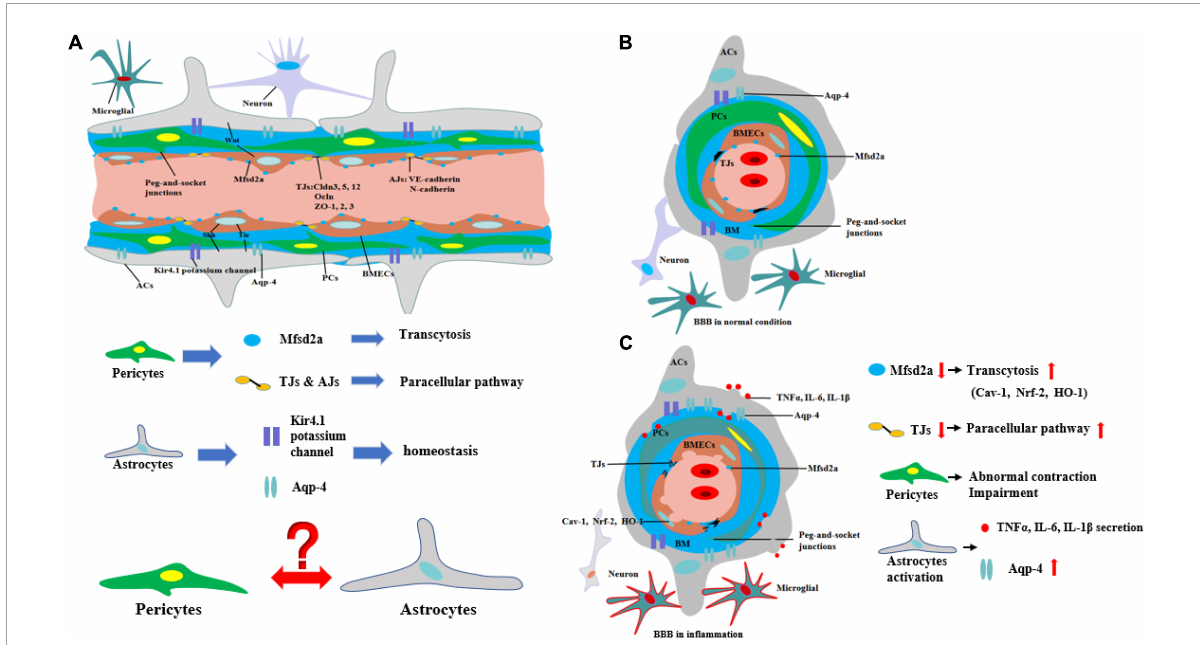
FIGURE1 Structure and biomechanisms of blood – brain barrier during physical or inflammation. (A) The structure of BBB from longitudinal section during physical condition. PCs control the transcytosis and paracellular pathway of BBB by regulating the expression of Mfsd2a and TJs. The structure of potassium channel of Kir4.1 potassium channel and Aqp-4 on ACs regulates the homeostasis of CNS. However, the relationship between ACs and PCs is still unknown. (B) The structure of BBB from cross-section during physical condition. (C) The structure of BBB from cross-section during inflammation. During inflammation, the expression of Mfsd2a is decreasing, which is negatively correlated with transcytosis of BBB. The level of TJs is decreasing, which means the paracellular pathway of BBB is increasing. Moreover, PCs are abnormal contracted and impairment. In addition, ACs are activated to secrete pro-inflammatory cytokines and the level of Aqp-4 is increasing, which is correlated with the deterioration of CNS diseases or